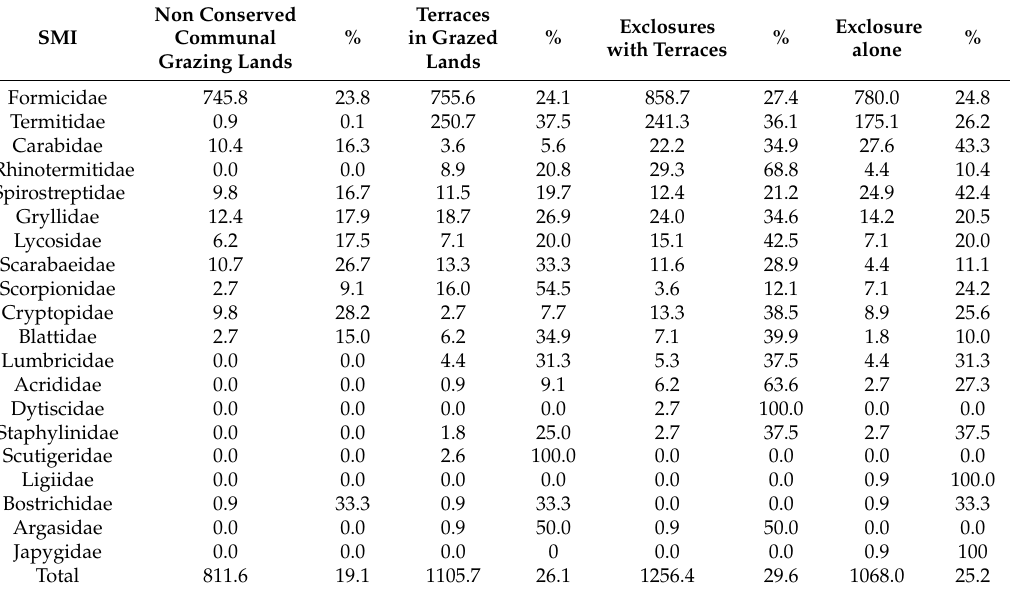
Table 3. Effect of SWC on abundance of soil macroinvertebrates (individuals m − 2 ).